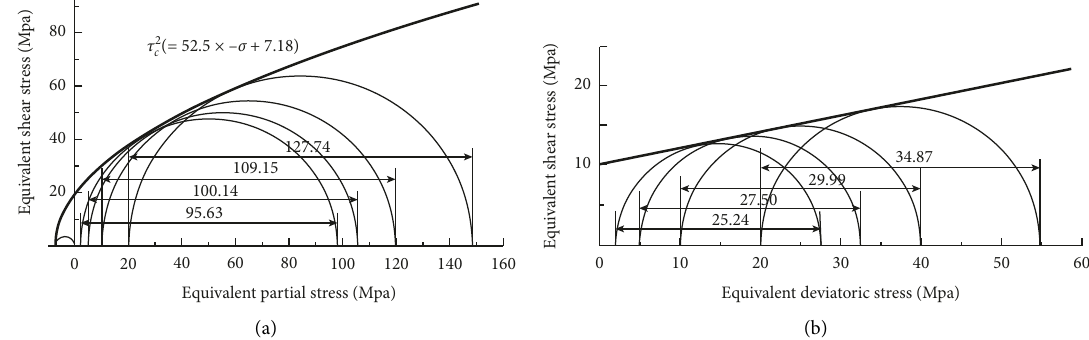
Figure 4: Stress circle and strength envelope of the specimen in triaxial compression test based on (a) the nonlinear discrete interface bonded model and (b) the parallel bonded